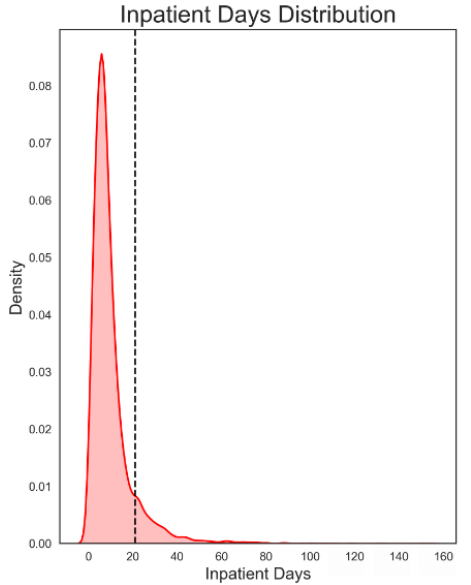
Figure 1. Length of stay. Cutoff point for outliers: 21 days. The bivariate analysis (Table 2) revealed significant differences in several of the vari- Table 2. Bivariate study. Mortality-associated factors in the training cohort. ables. Thus, positive associations with mortality were obtained for female sex (ORu 1.792, 95% CI: 1.720–1.787), readmission (OR 2.324, 95% CI 2.165–2.493) and among